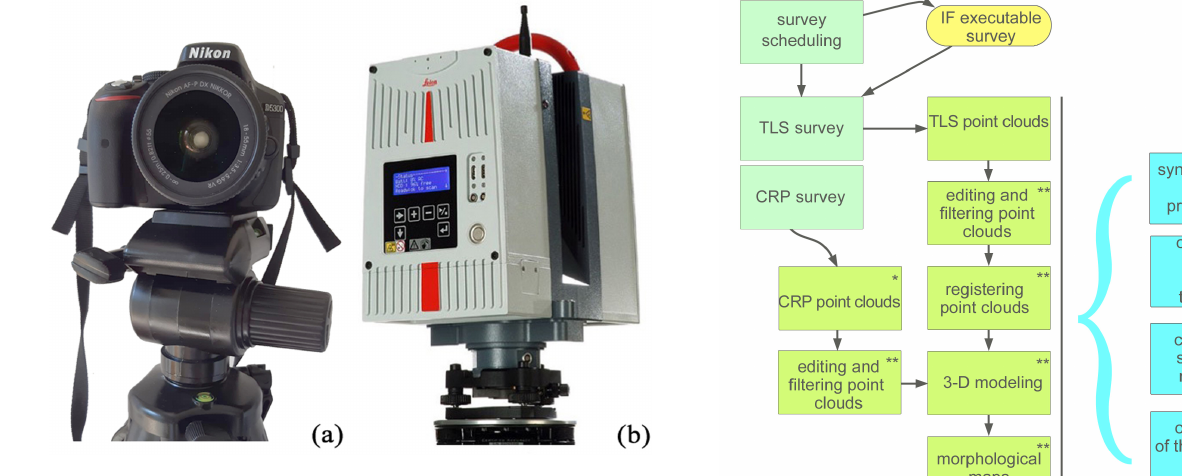
Figure 5. (a) The Nikon D5300 Camera. (b) The Leica HDS-6200 TLS.